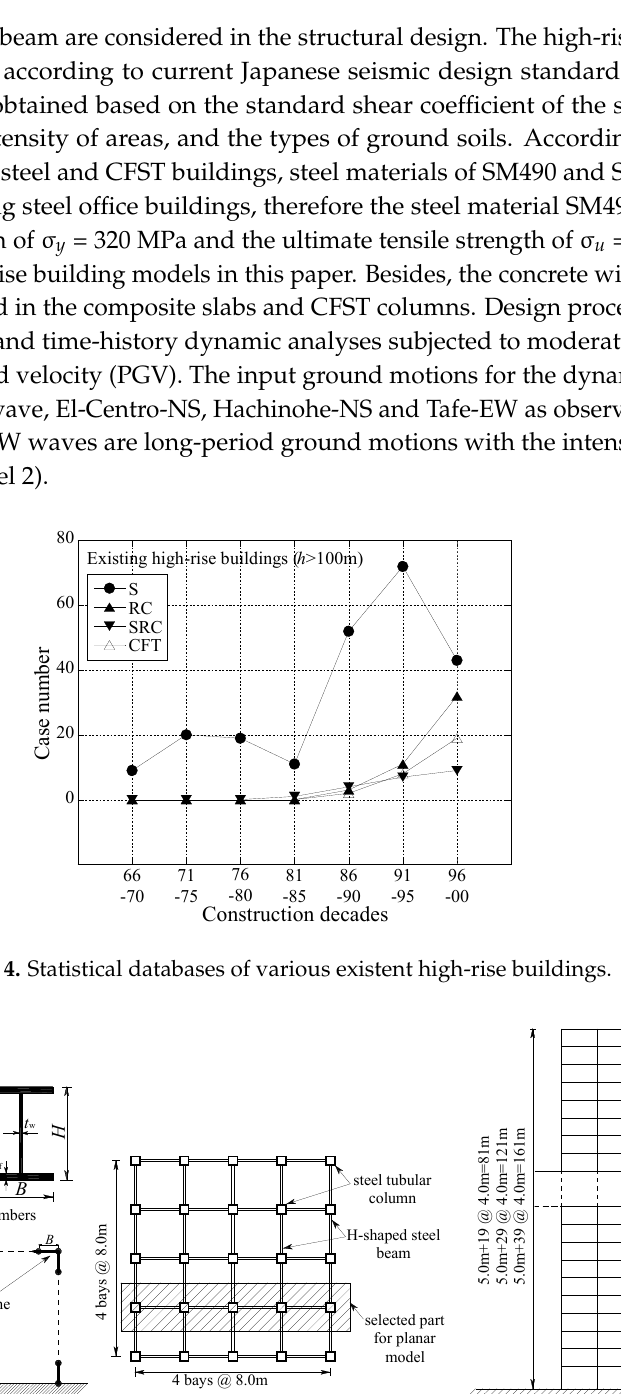
Figure 4. Statistical databases of various existent high ‐ rise buildings.